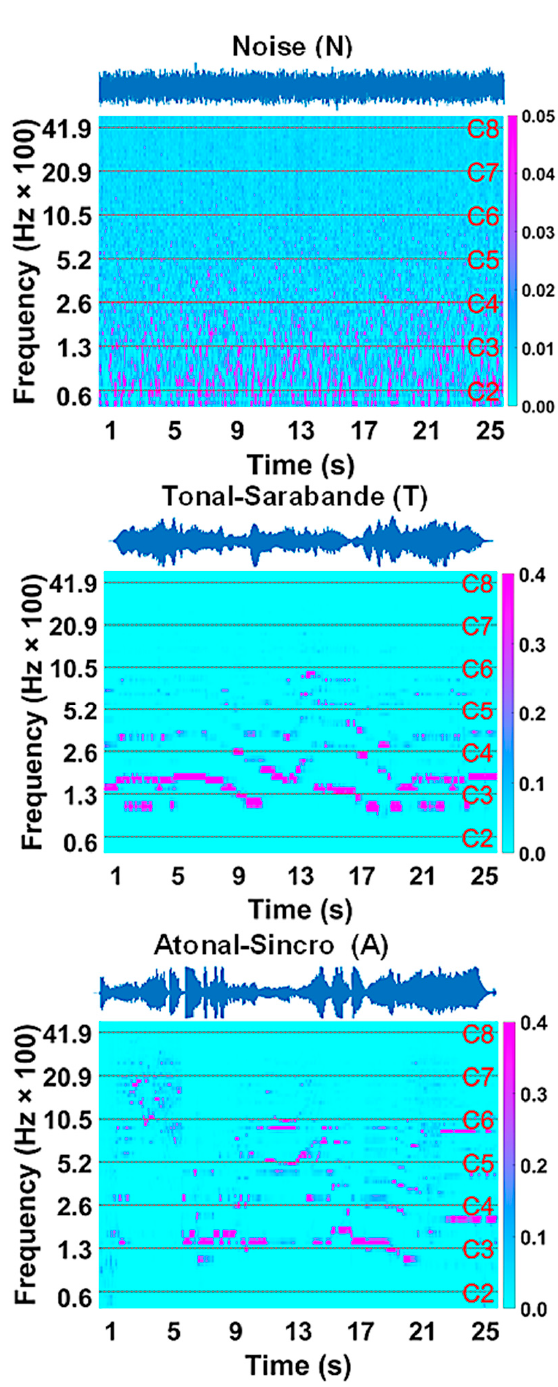
Figure 1. From top to bottom are: the acoustic signal/stimulus and time-frequency spectrum of the pink noise (N), baroque tonal Sarabande excerpt (T) and, contemporary atonal music excerpt Sincro (A). The dashed line in the spectra delimits the successive octaves of the piano keyboard; for each octave, the frequency level of the musical note C is indicated on the right of the frequency axis. Time axes in seconds (s) for signals and spectra, and color bar (right side) in relative power